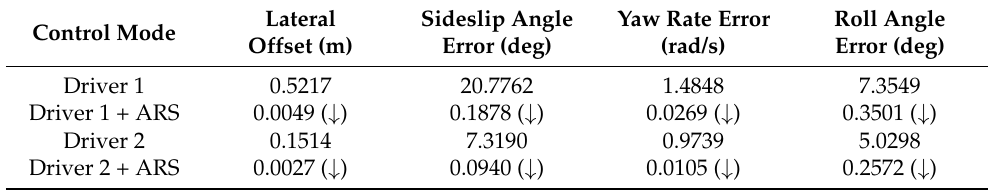
Figure 7. Front and rear steering angles of vehicles in Case A: ( a ) front steering angle; ( b ) rear steering angle. Table 4. Maximum control errors of active safety performances in Case